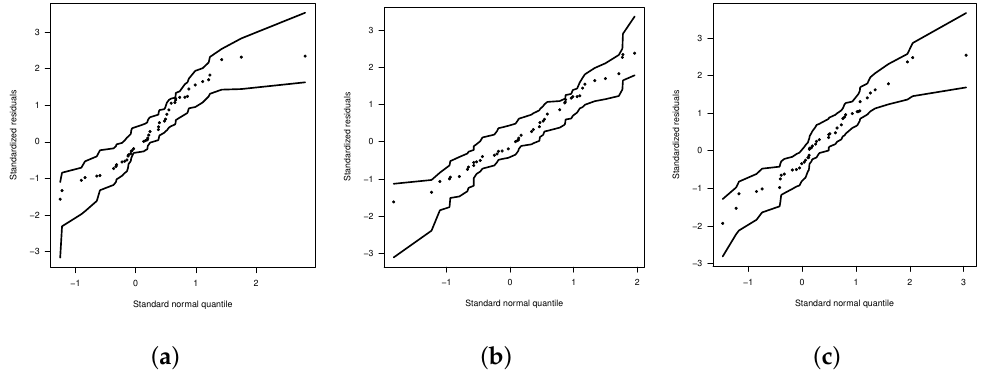
Figure 5. Confidence envelope plots for the fitted models ( a ) N, ( b ) SHN, and ( c )